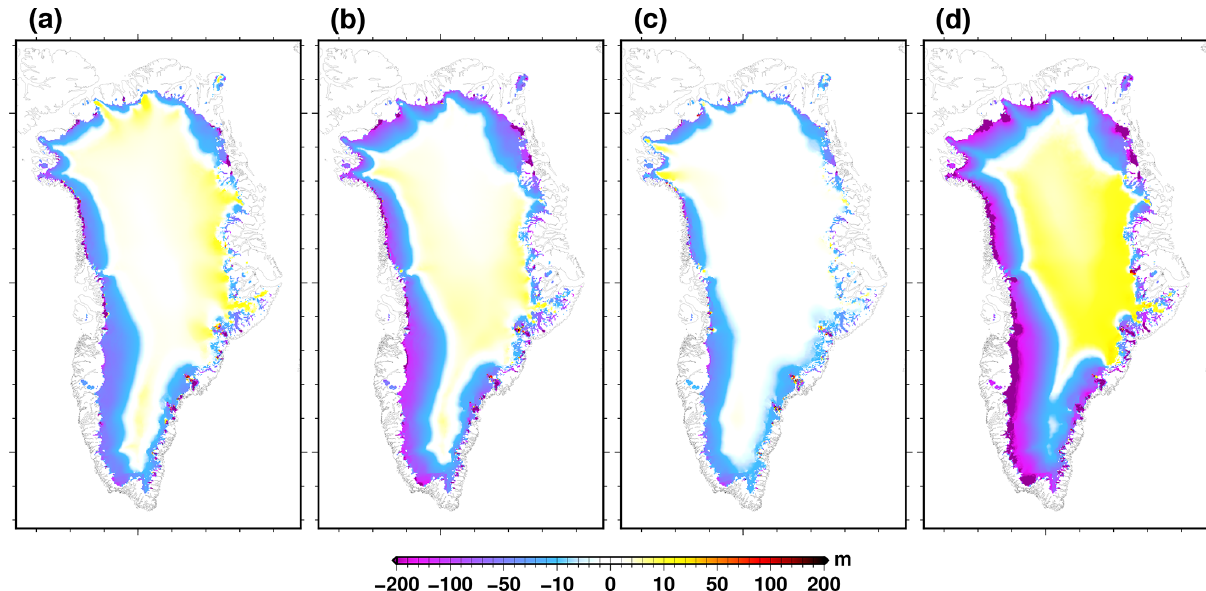
Figure 8. Simulated ice thickness change (2100–2015) for (a) CSIRO-Mk3.6 (RCP8.5), (b) MIROC5 (RCP8.5), (c) MIROC5 (RCP2.6) and (d) UKESM-CM6 (SSP585) climate forcing. The medium oceanic sensitivity has been used for this figure, except for UKESM-CM6 (d) , for which we use the high oceanic sensitivity. The ice thickness change shown here is corrected for the ice thickness change (2100–2015) in the control experiment ctrl_proj